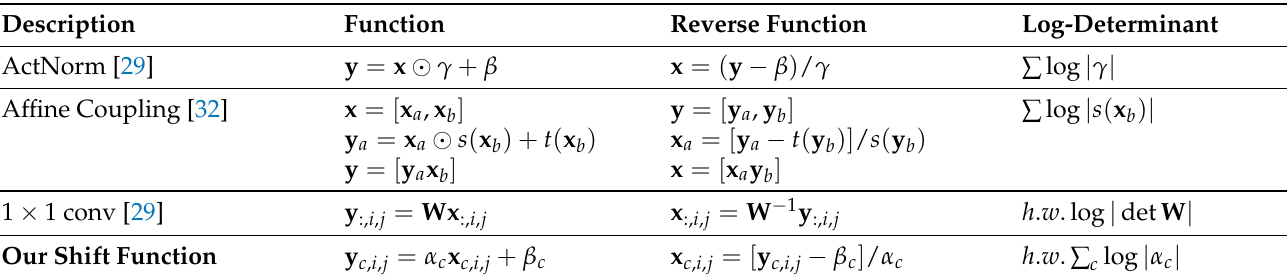
Table 1. Comparative invertible functions in several generative normalizing